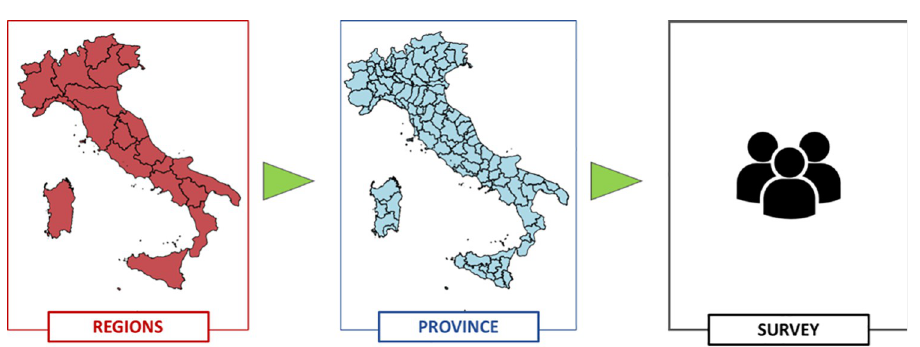
Fig 14. The workflow followed for the research. Starting from the regional analysis (red), the focus of the research was restricted to the province (blue), up to analyzing a sample of the population through the administration of a survey